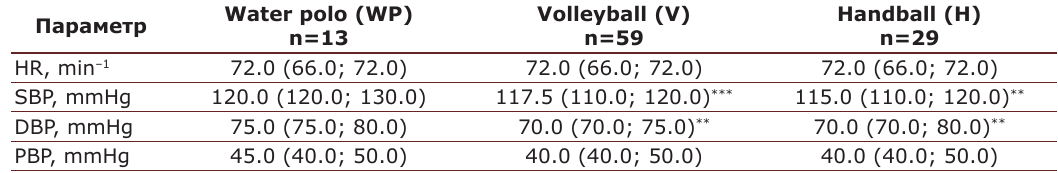
Table 2. Average parameters of athletes’ cardiovascular system activity in the initial state, M (25;